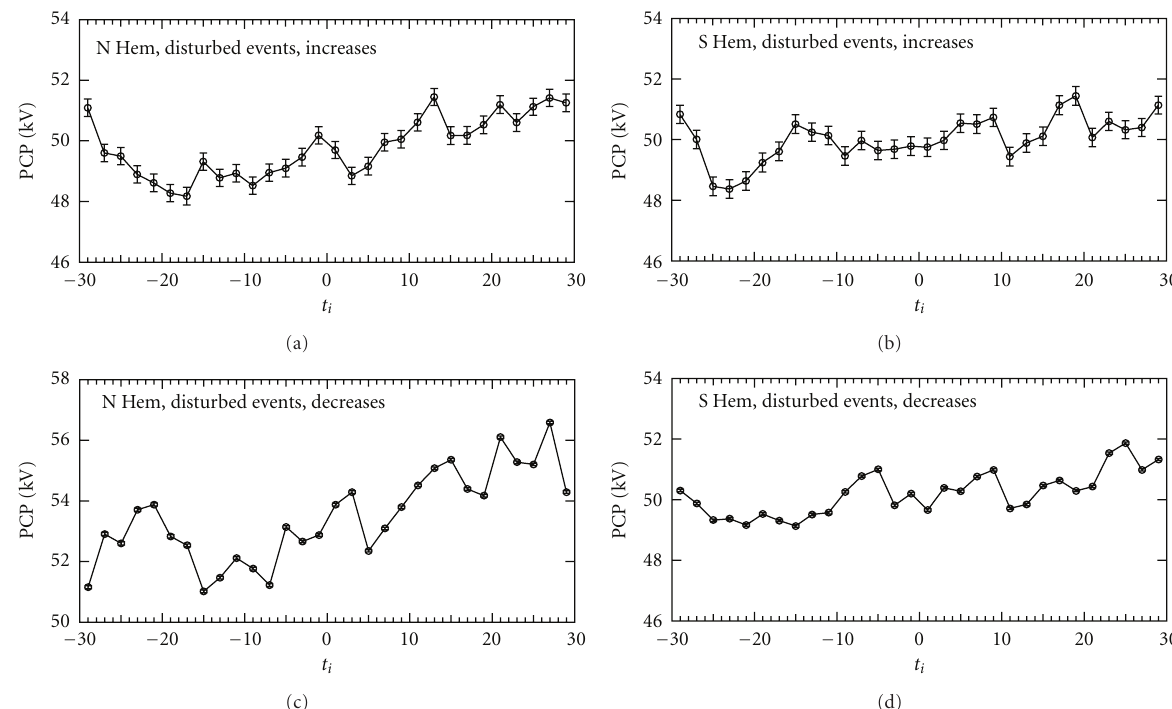
Figure 4: V av ( i ) (PCP) as a function of the scan time, t i , for Disturbed events: (a) NH Is; (b) SH Is; (c) NH Ds; (d) SH